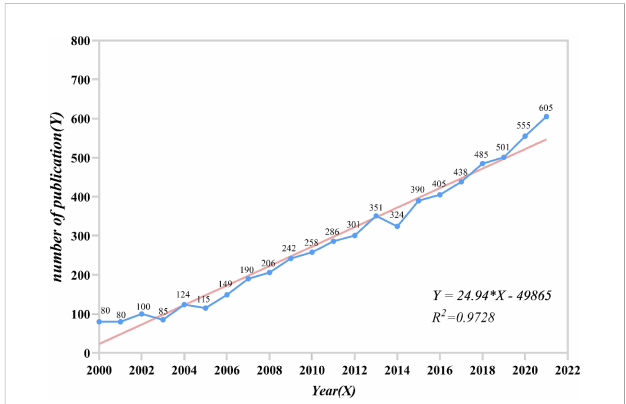
FIGURE 2 The number of published papers from 2000 to